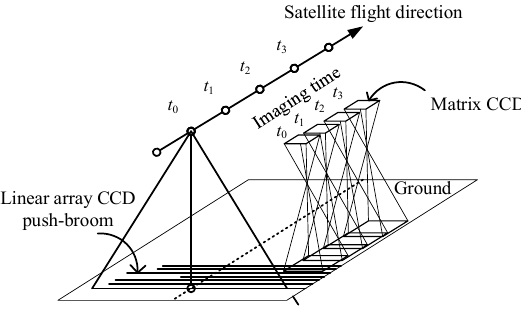
Figure 5. Imaging schematic of a small matrix charge-coupled device (CCD) and linear array CCD.